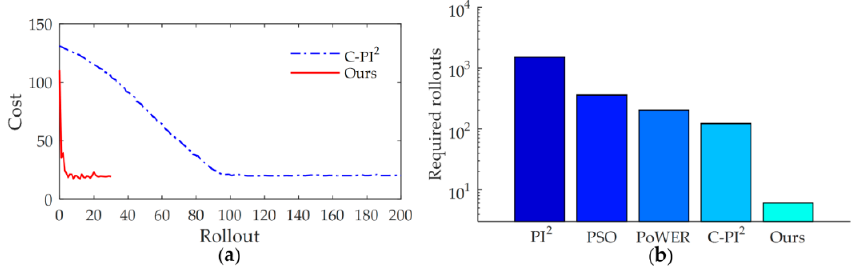
Figure 21. ( a ) The cost curve of the learning process. ( b ) Comparison of learning speed with other learning variable impedance control methods.